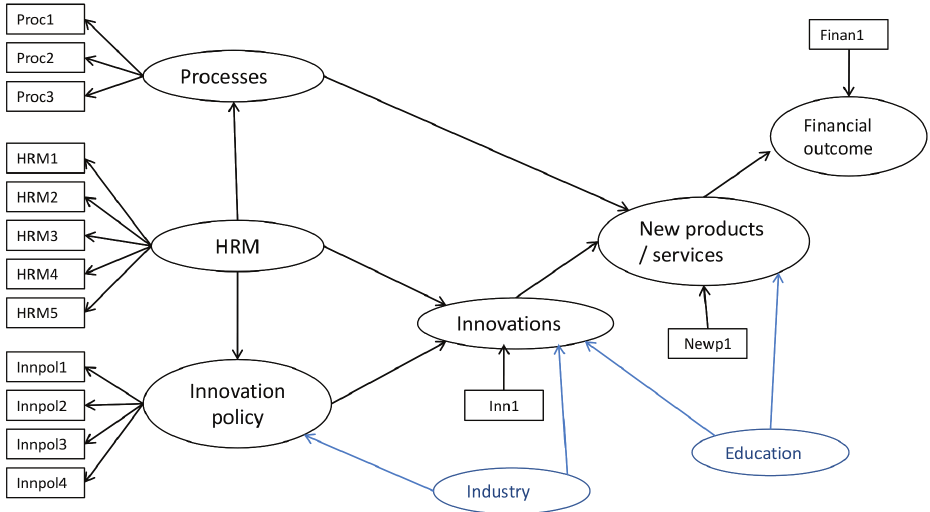
Fig. 1. The conceptual